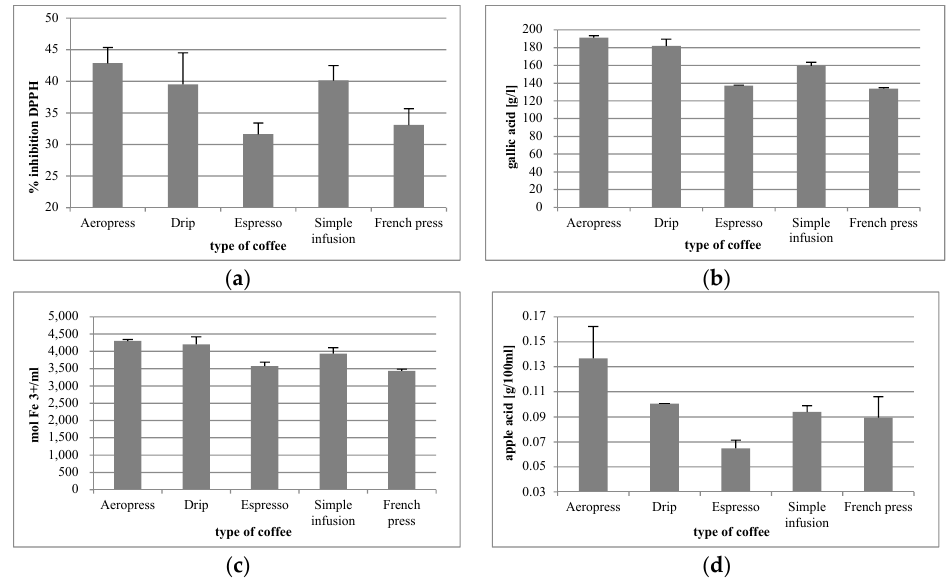
Figure 5. Antioxidant potential ( a ), total polyphenol content ( b ), reduction potential ( c ), and acidity ( d ) of coffee beverages made using different methods. DPPH: 2,2-diphenyl-1-picrylhydrazyl. The lowest total polyphenol content was found in the co ff ee from the French press (133.90 g gallic acid / L) and the highest was observed in the Aeropress brew (191.29 g gallic acid / L) (Figure 5b). The di ff erences between the respective co ff ee brews were statistically significant, except for the di ff erence between the co ff ee from the French press vs. espresso ( p = 0.4733). The reduction potential of the coffee brews ranged from 3435.06 mol Fe 3+ /mL for the coffee from the French press to 4298.19 mol Fe 3+ /mL in the Aeropress coffee (Figure 5c). The differences in the respective brews were statistically significant. The differences between Aeropress vs. drip ( p = 0.5799) and espresso vs. French press ( p = 0.2392) were demonstrated to be statistically insignificant. The acidity of co ff ee brews ranged from 0.14% (espresso) to 0.6% (Aeropress) (Figure 5d). The only statistically insignificant di ff erences in acidity were drip vs. French press ( p = 0.4602), drip vs.